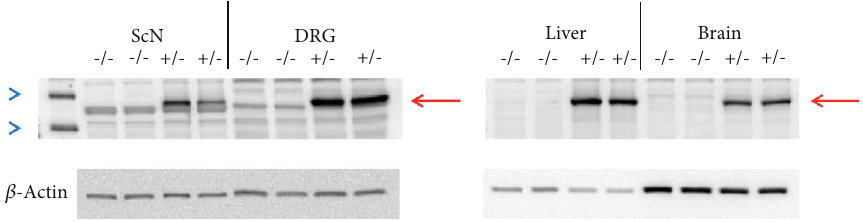
Figure 1: Western blot of tissues isolated from mice ubiquitously overexpressing human 15-LOX-1 (+/ − ) or wild-type littermates ( − / − ). The red arrow indicates the 15-LOX-1 protein. The molecular weight of 15-LOX-1 is 72kDa. The blue arrowheads are markers for the 50 and 75kDa molecular weight